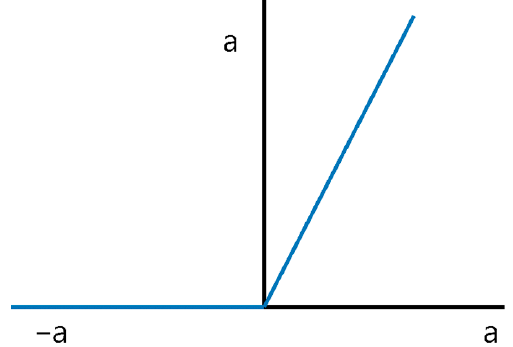
Figure 8. Graph of the ReLU function.